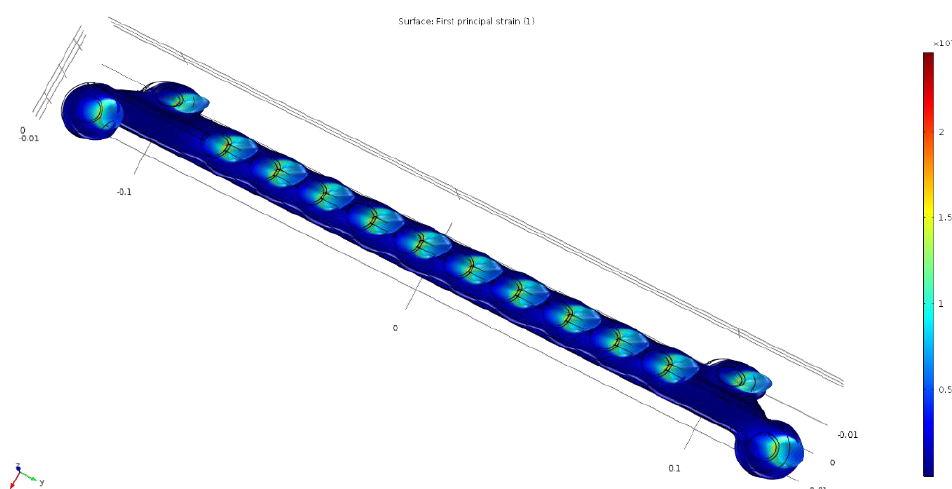
Figure 23. First principal strain of newly developed plate bent for 40°. Bent, 50°